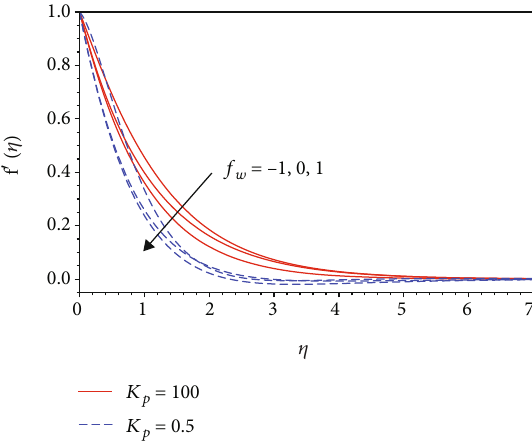
Figure 1: Velocity pro fi les (second-grade fl uid) for di ff erent values when M = 0 : 5 andRc = 1 of f w